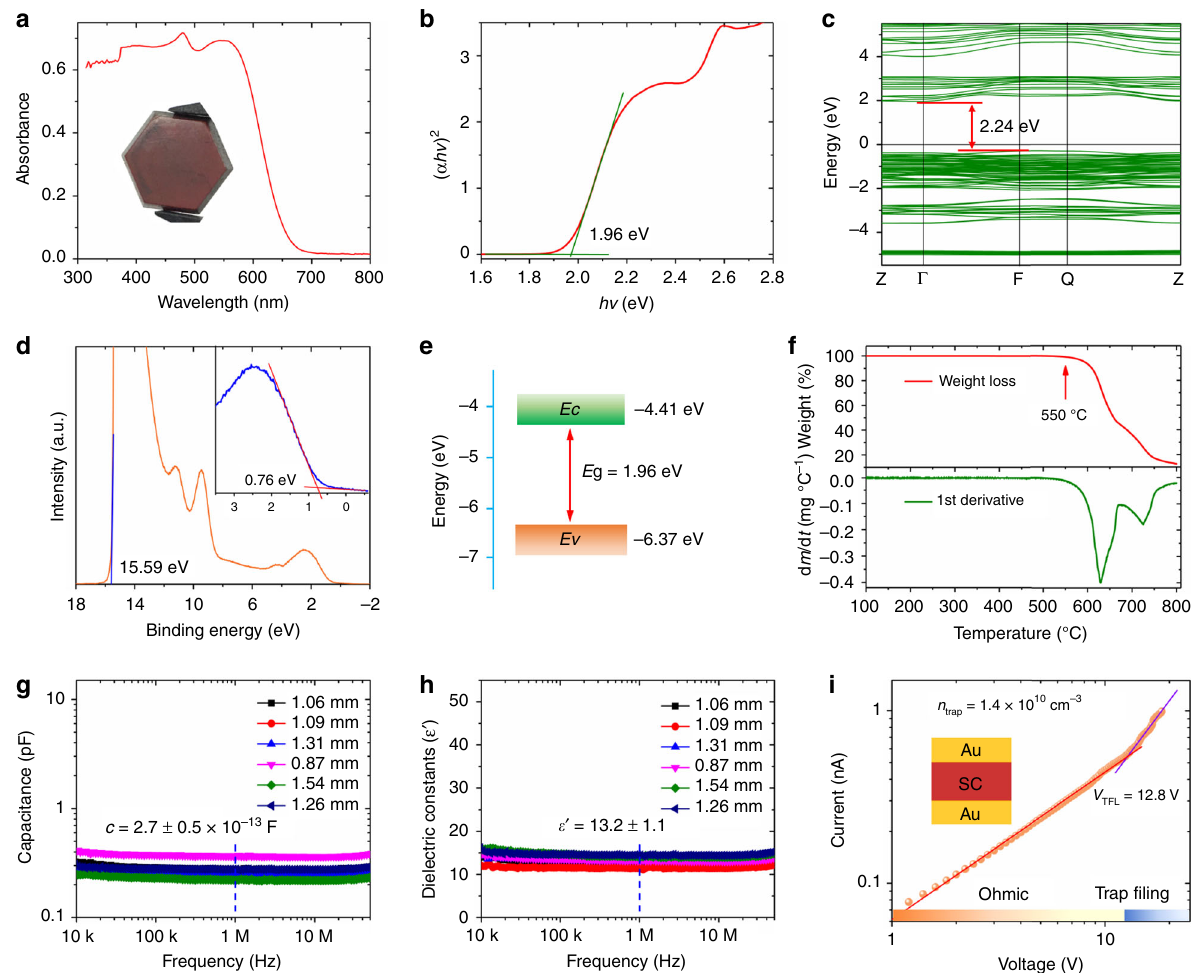
Fig. 3 Optical properties and trap state density of Cs 3 Bi 2 I 9 PSC. a Optical absorption spectrum of Cs 3 Bi 2 I 9 . b Tauc plot of the Cs 3 Bi 2 I 9 from the absorption spectrum. c Calculated electronic band structure of Cs 3 Bi 2 I 9 without considering the spin-orbit coupling (SOC) effect. d UPS spectrum of the Cs 3 Bi 2 I 9 PSC. Inset: linear extrapolation in the low-binding-energy region. e Energy band diagram of the Cs 3 Bi 2 I 9 PSC calculated from the Tauc plot and UPS result. f Thermogravimetric analysis (mass loss vs. temperature) plot and its fi rst order derivative. g Frequency-dependent capacitance and h corresponding dielectric constant curves. i Current – voltage curve of a hole-only Cs 3 Bi 2 I 9 PSC device. The top-left inset provides an illustration for the hole-only device structure Au/Cs 3 Bi 2 I 9